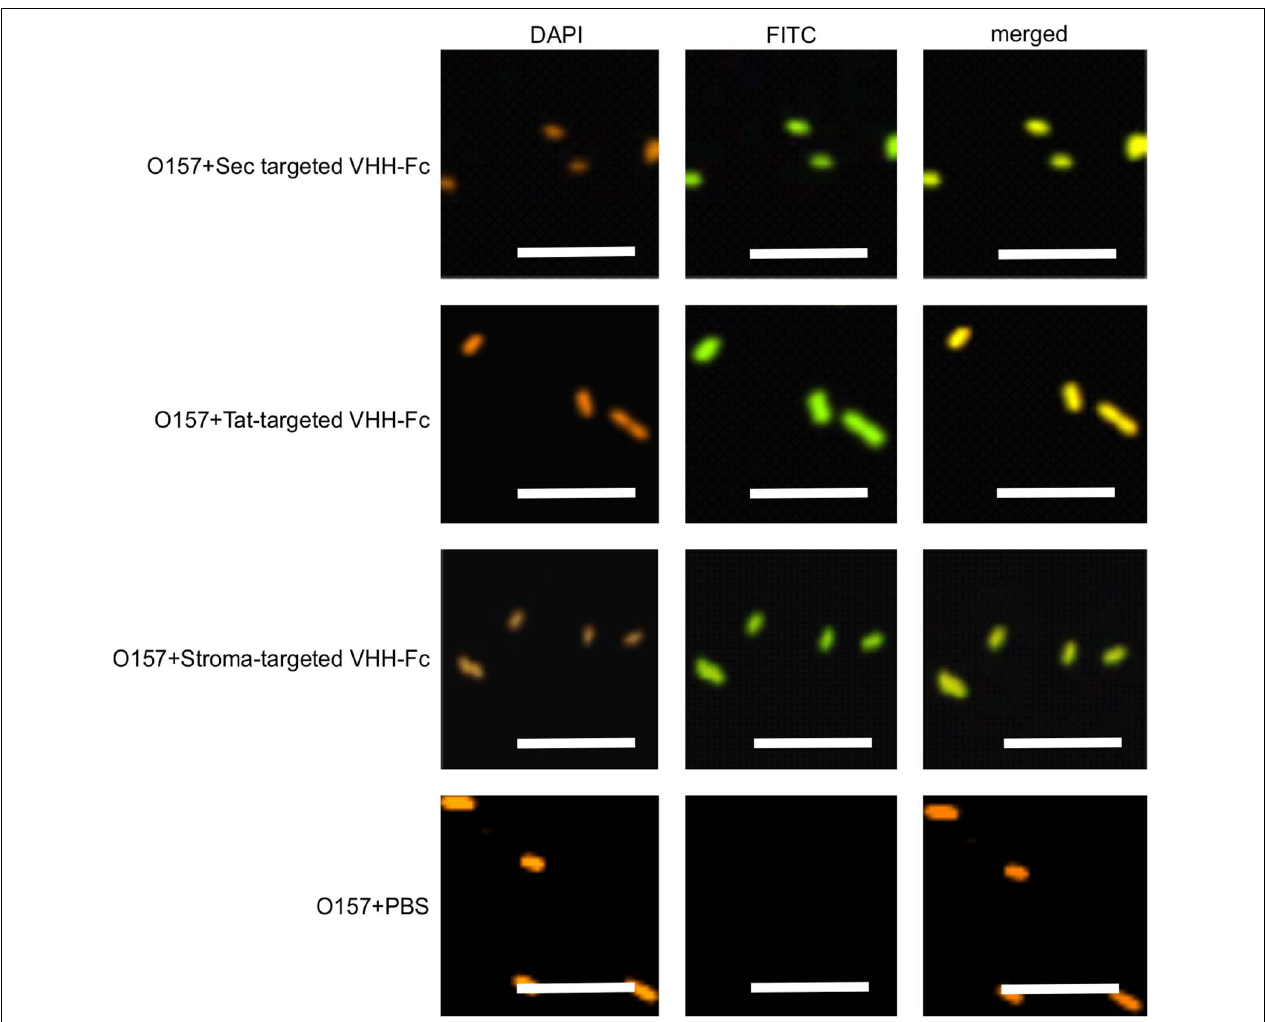
FIGURE 5 | V H H-Fc targeted with either Sec, Tat or stromal transit peptides can bind O157:H7 cells. Shown are confocal images of V H H-Fc targeted with either Sec, Tat or stromal signals incubated with EHEC O157:H7. DAPI was used to visualize EHEC cells (orange) and a FITC-conjugated antibody (green) was used to immunolabel the Fc specifically. Size bar = 10 µ